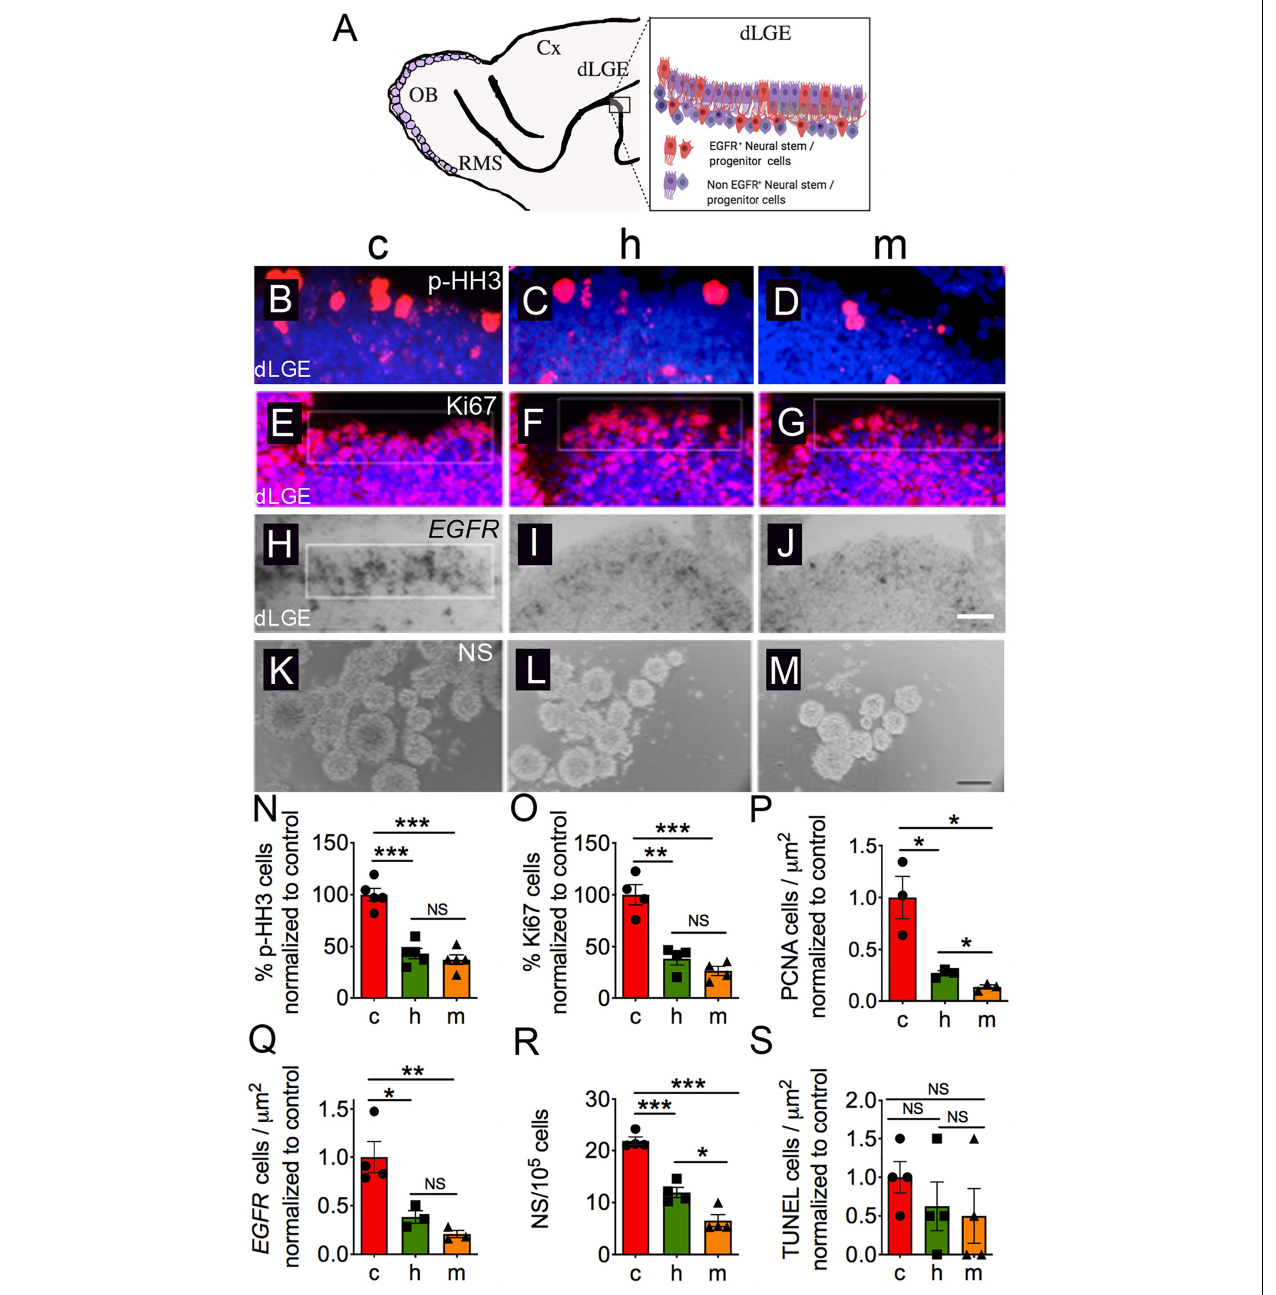
FIGURE 4 | Haploinsufficient Jag1 signaling strongly attenuates neuronal division in the dLGE. (A) Schematic cartoon of the dLGE. E17.5 sagittal brain sections show reduced immunostaining of (B–D,N) p-HH3 (c, n = 5; h, n = 5; m, n = 5) and (E–G,O) Ki67 (c, n = 4; h, n = 4; m, n = 4) antibodies in the heterozygous and homozygous mice in the dorsal LGE. Sections were counterstained with DAPI (blue). Quantitations were performed for p-HH3 + and Ki67 + cells (white box; area = ∼ 82,000 µ m 2 ) by counting the number of positive cells over the total number of DAPI + cells. Similarly, (P) quantification of PCNA shows a significant reduction in Jag1 mutants (c, n = 3; h, n = 3; m, n = 3). (H–J,Q) Reduction in EGFR + cells in the heterozygous ( n = 3) and homozygous mutants ( n = 3) in the dorsal LGE (c, n = 4). Quantitation was performed by counting the number of EGFR + cells in the boxed region (area = ∼ 74,880 µ m 2 ) of each image, determining the number of positive cells micron. (K–M,R) Cells isolated from the dLGE show fewer numbers of neurospheres (c, n = 7; h, n = 7; m, n = 7; seven randomly selected pictures were used to quantify per genotype from four independent embryos). Scale bar = 100 µ m. Neurosphere quantitation was performed at seven DIV by counting the total number of neurospheres at 25 × magnification to determine the number of NS per 10 5 cells. (S) Quantification of cell death as determined by TUNEL in the LGE showed no significant differences between mice (c, n = 6; h, n = 6; m, n = 6). All graphs show average ± SEM. Key to statistics: * p < 0.05; ** p < 0.01; *** p < 0.001, respectively, in comparison to control or heterozygous; NS, not significant. A minimal of three independent embryos was counted and one to four sections were selected from each genotype. Scale bar = 100 µ m for panels (B–J) . OB, olfactory bulb; RMS, rostral migratory stream; Cx, cortex; dLGE, dorsal lateral ganglionic eminence; NS,